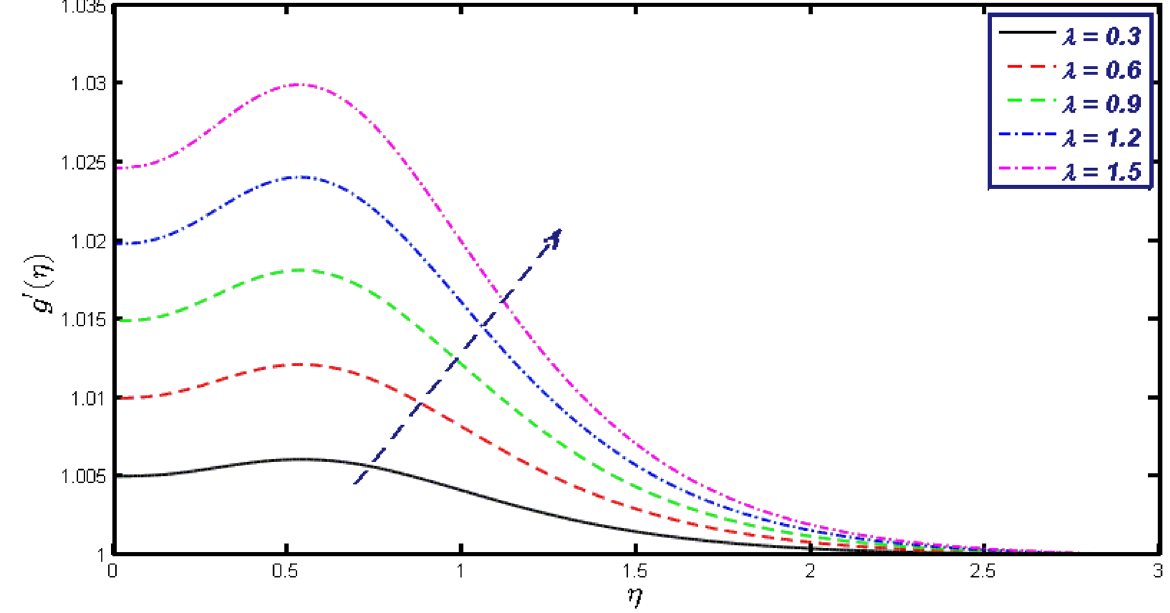
Figure 17. g ′ (η) field for distinct values of (cid:31) .